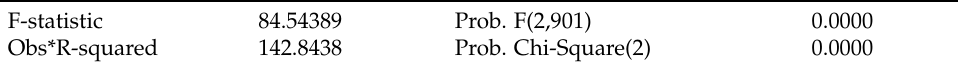
Table 4. Heteroskedasticity test: ARCH.